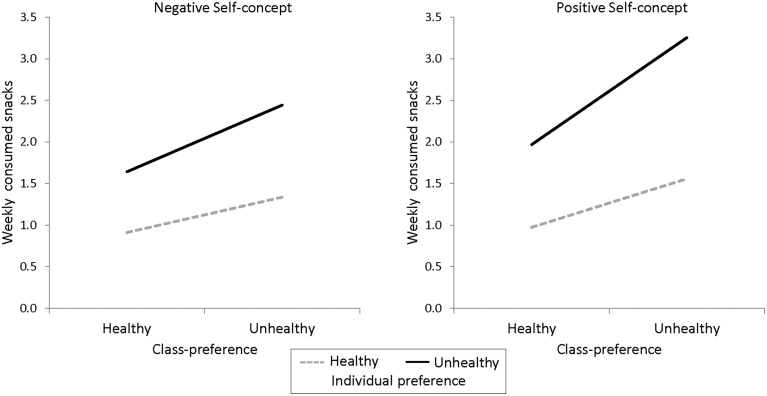
Simple effects of class preference. Simple slope effects for |1SD| in each variable. The snacking frequency refers to snacking of each single snack.